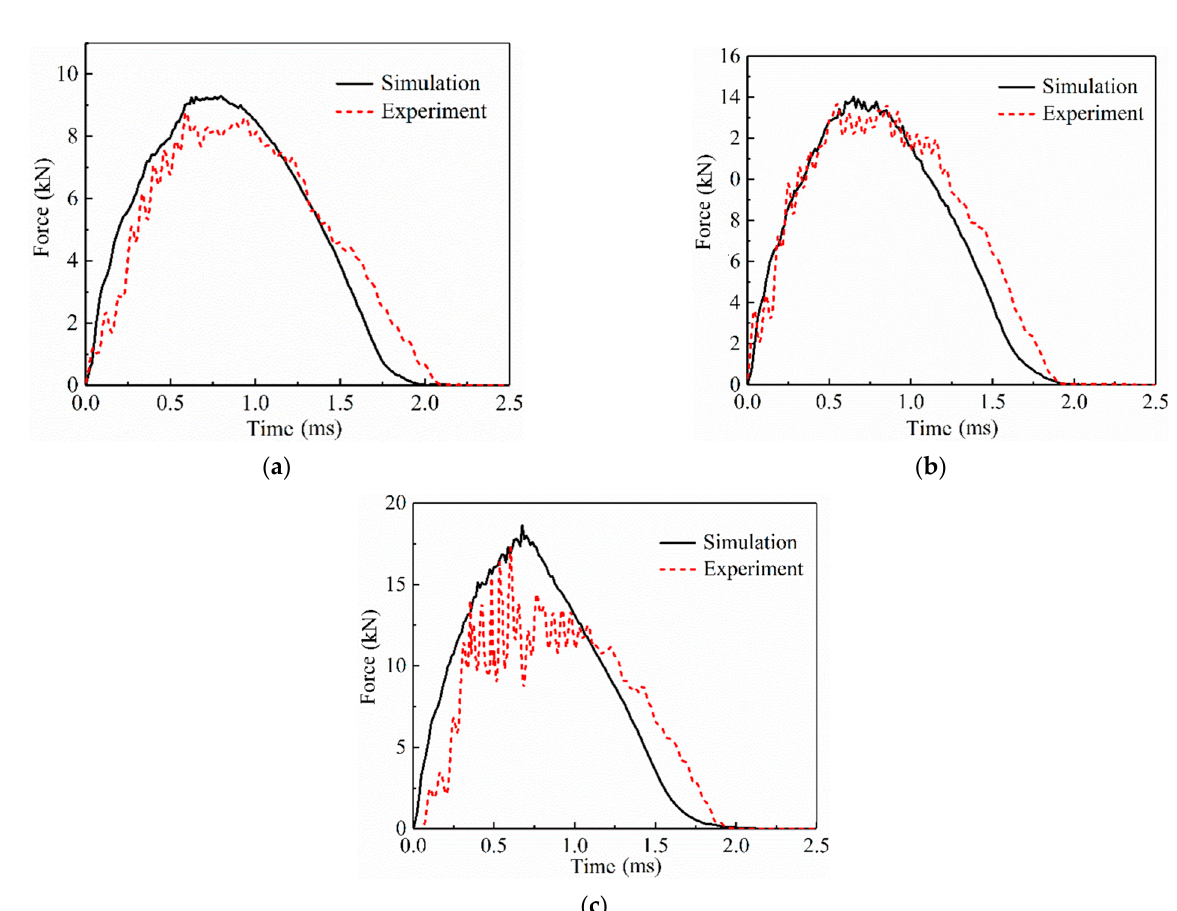
Figure 5. Curves of the impact force-time of the SLJs adhesively bonded structure of CFRP laminate under different impact energies. ( a ) 10 J; ( b ) 20 J; and ( c ) 30